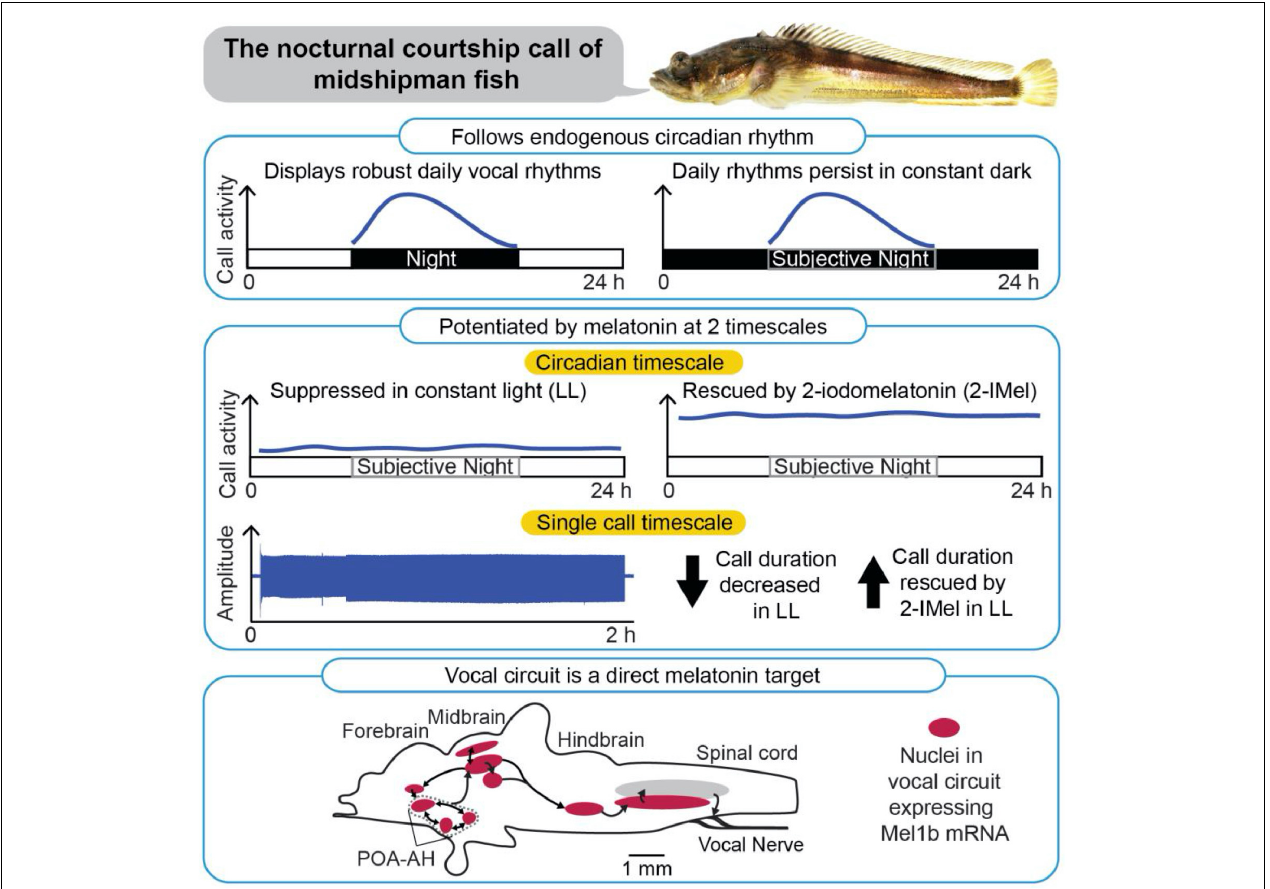
FIGURE 3 | Patterning of social acoustic signaling in the nocturnally breeding, plainfin midshipman fish ( Porichthys notatus ) at multiple timescales, from day–night rhythms to call temporal properties. (Top) Courtship vocalizations exhibit an endogenous circadian rhythm under constant dark conditions. (Middle) Courtship vocalizations are suppressed under constant light (LL), but systemic delivery of melatonin analog (2-IMel) rescues their daily occurrence (circadian timescale), including their duration (single call timescale). (Bottom) Sagittal view of midshipman brain (rostral is to the left) depicting robust expression of melatonin receptor lb mRNA transcripts in evolutionarily conserved neuroendocrine and vocal networks, including the preoptic area-anterior hypothalamus (POA-AH). From Feng and Bass